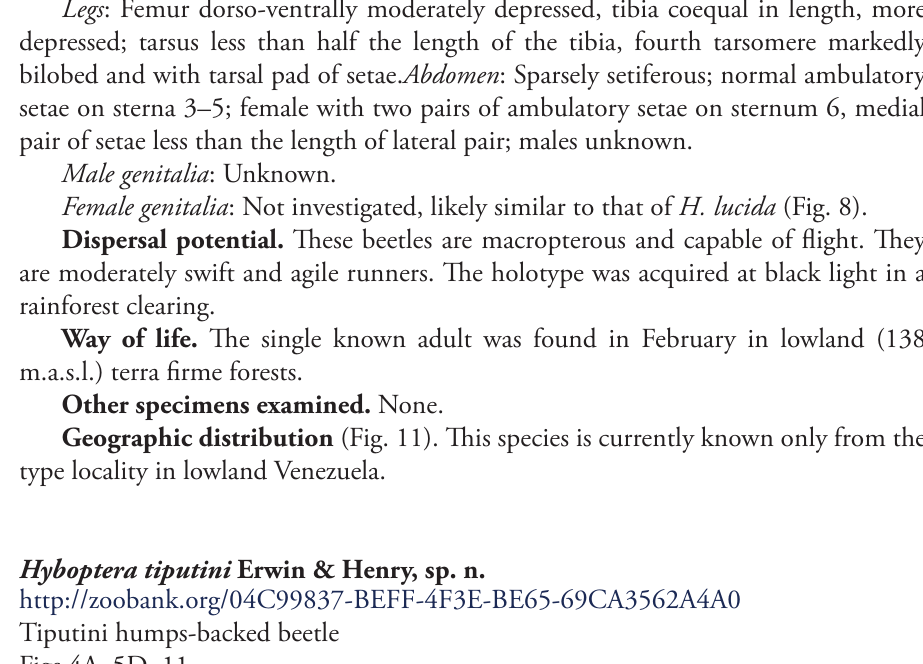
(heading 101.46°) Coca, Tiputini Biodiversity Station, Erwin Harpia Plot: transect